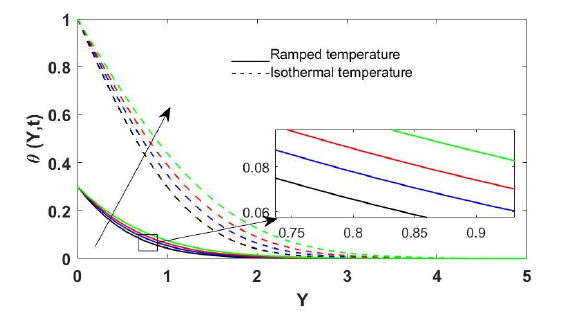
Figure 16: Temperature profiles for different values of R = 0.1, 0.2,